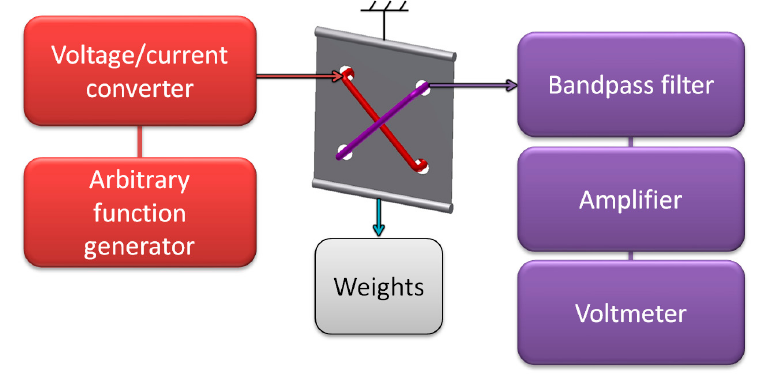
Figure 7. Schematic diagram of the measurement test stand.